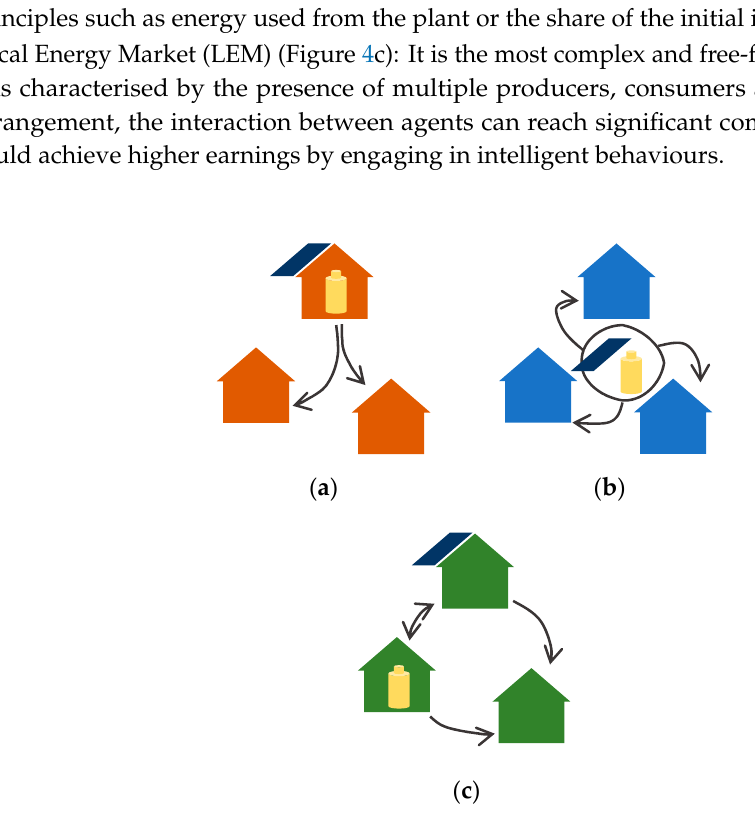
Figure 4. Possible ownership structures organised in three main families: Local Energy Provider (LEP) ( a ); Local Energy Community (LEC) ( b ); and Local Energy Market ( c ). (LEP) ( a ); Local Energy Community (LEC) ( b ); and Local Energy Market ( c